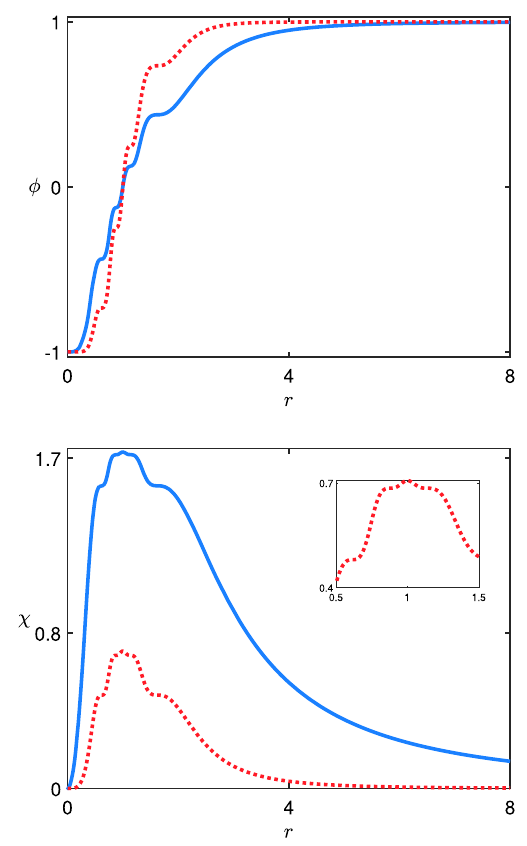
Fig. 12 The radial component of the electric field (top) with e = 1 and the energy density (bottom) associated to the model in Sect. 4.1.2 for σ = 5, α = 2 and n = 2, with k = 1 (solid, blue line) and k = 2 (dotted, red line)